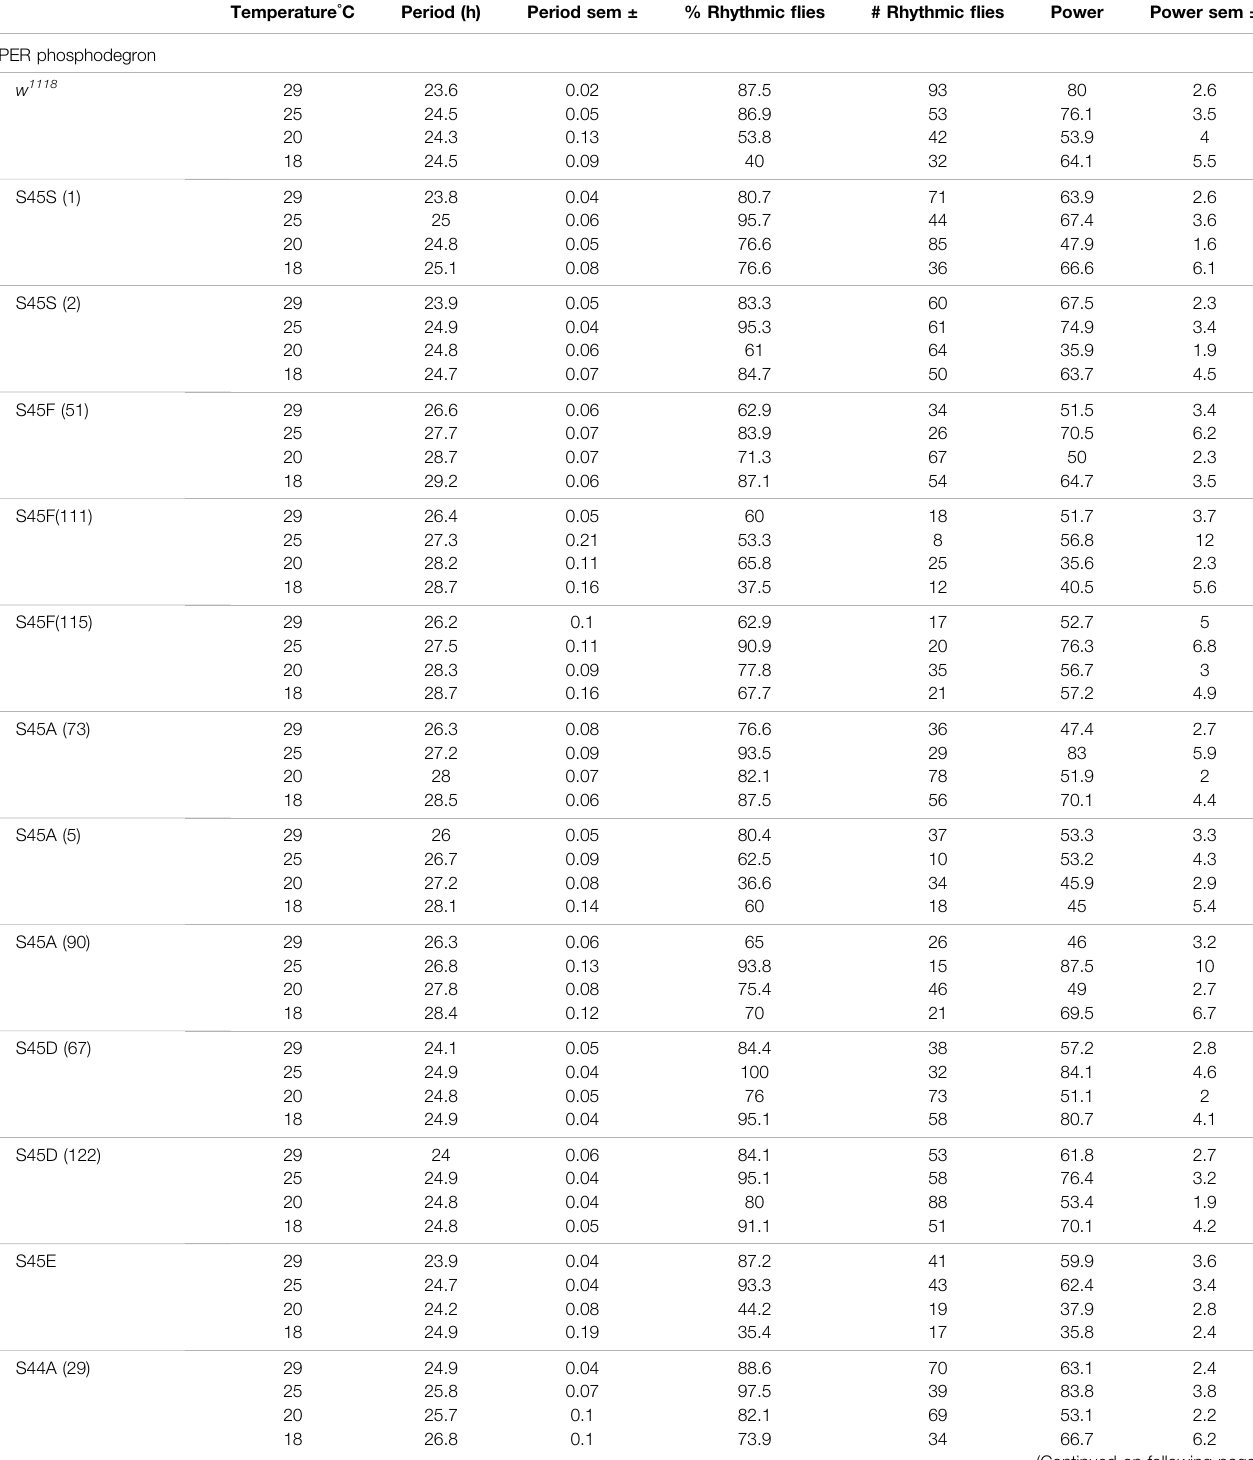
TABLE 1 | Circadian behavior of control and per mutant fl ies under different temperatures. Mutations in the phosphoclusters were generated by CRISPR/Cas9-mediated genome editing. Amino acid substitutions are indicated in the left column. w 1118 is a control strain. For the per s phosphocluster, per 0 fl ies were rescued with various transgenes. 13.2WT carries a wild-type per genomic region, while the other transgenes carry the indicated substitutions. AR = arrhythmic ND = Not done, N/A = Not